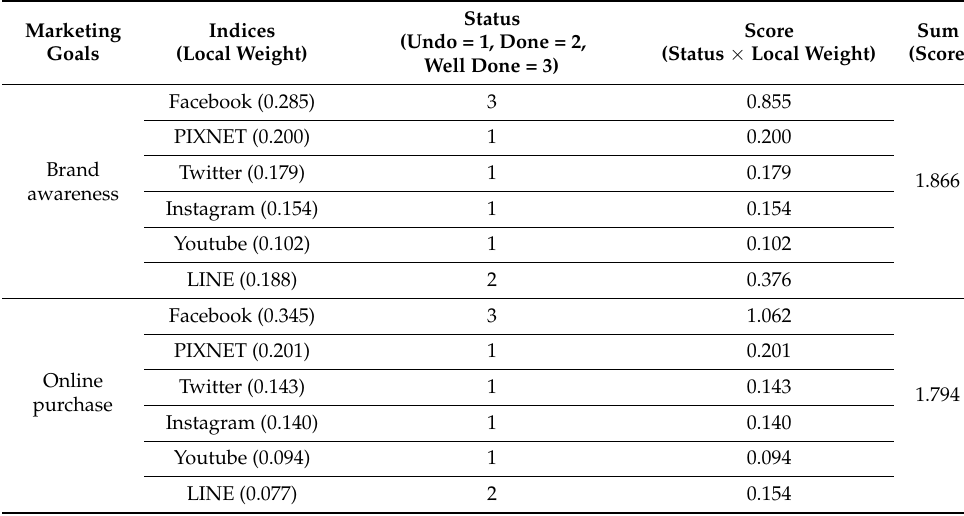
Table 5. Application of score sheet for examination of marketing goals for